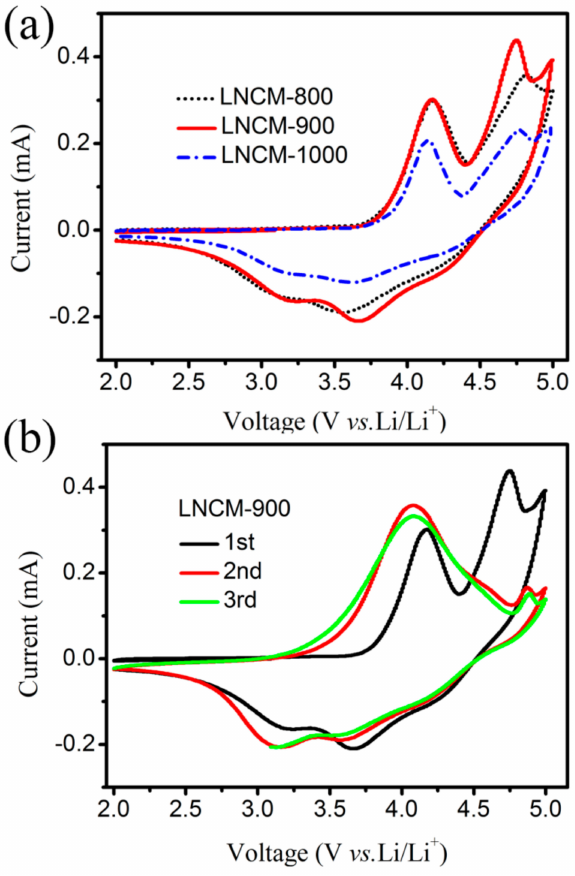
Figure 5. ( a )The initial cyclic voltammograms (CV) curves of LCNM-800, LCNM-900, and LNCM-1000, ( b ) The CV curves of